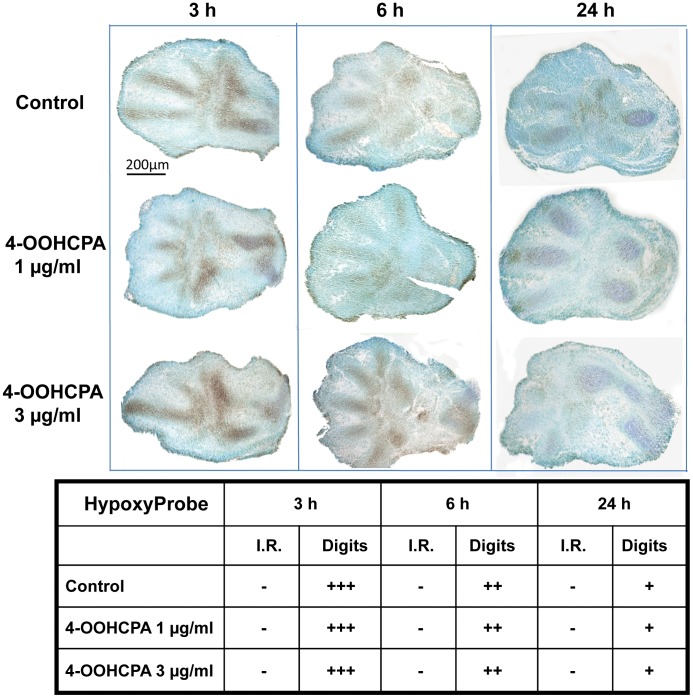
Detection of hypoxia in limbs using Hypoxyprobe.Hypoxyprobe™-1 reactivity was detected in the digit and core areas (Digit) of limbs where chondrogenesis occurs; staining in these areas was strong at 3 h and 6 h and diminished at 24 h. Hypoxyprobe reactivity was not observed in the interdigital regions (I.R.). No differences were observed between control and drug-treated limbs. Four separate replicates were done.